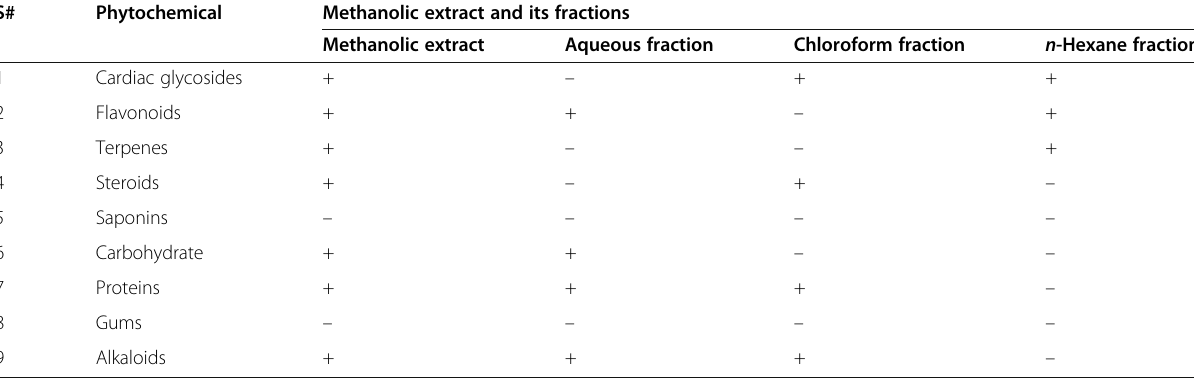
Performed the experiments in triplicate ( n =3)